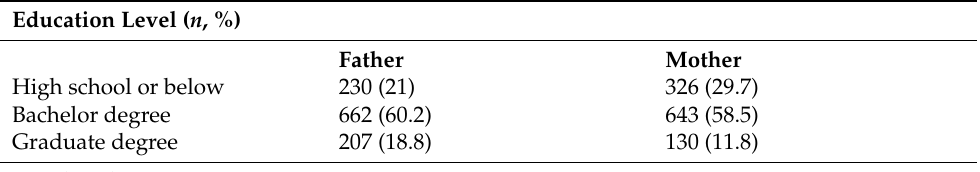
Table 4. The statistics of parents’ education level and family affluence level for Sample 3 ( n = 1099).